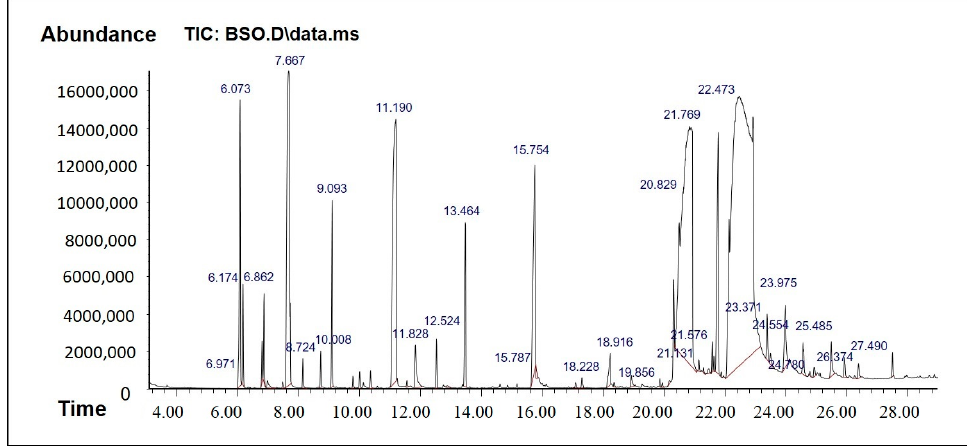
Figure 2. GCMS Chromatogram of BSO.